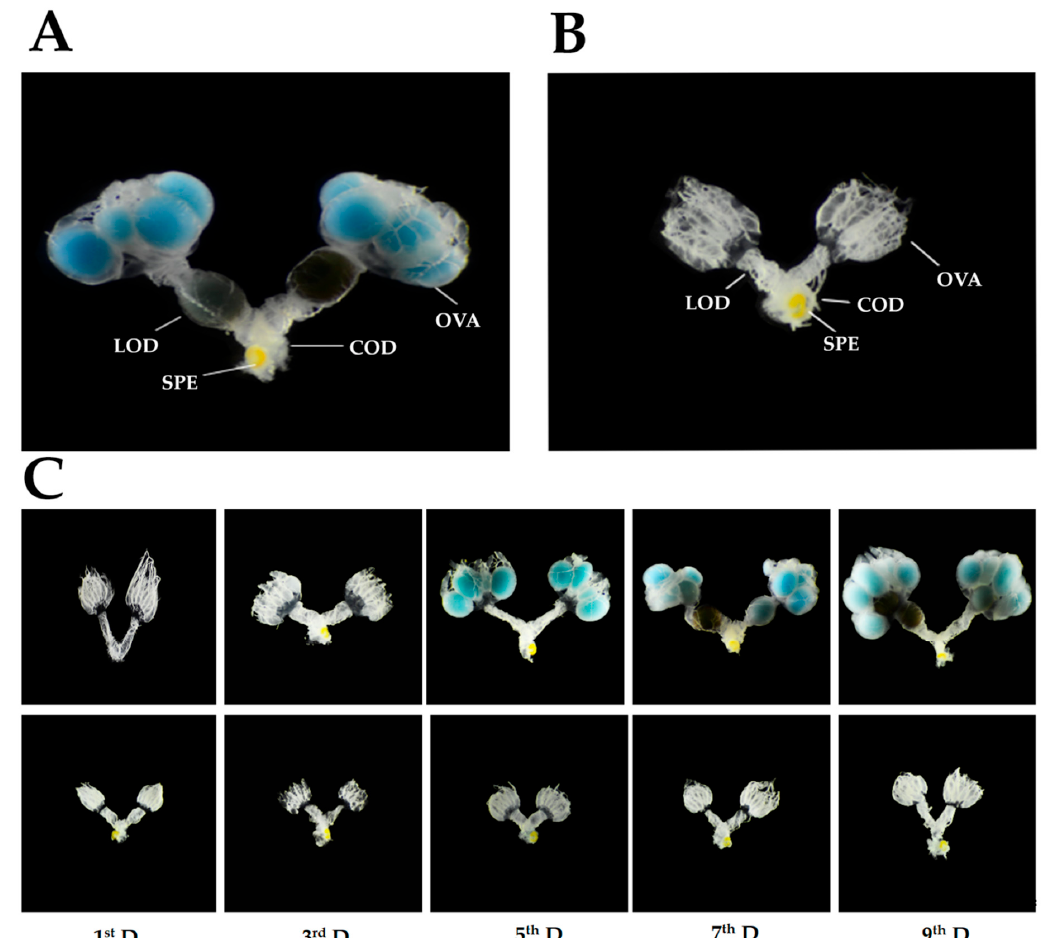
Figure 1. D evelopment of the internal reproductive organs of the prereproductive ( A ) and prediapause females ( B ) after 9 days of adult emergence. Differences in the development of ovaries in the prereproductive (upper) and prediapause (lower) adult females of R. pedestris at each day of observation (C). Ovariole(OVA), lateraloviduct(LOD), common oviduct(COD), spermatheca(SPE).